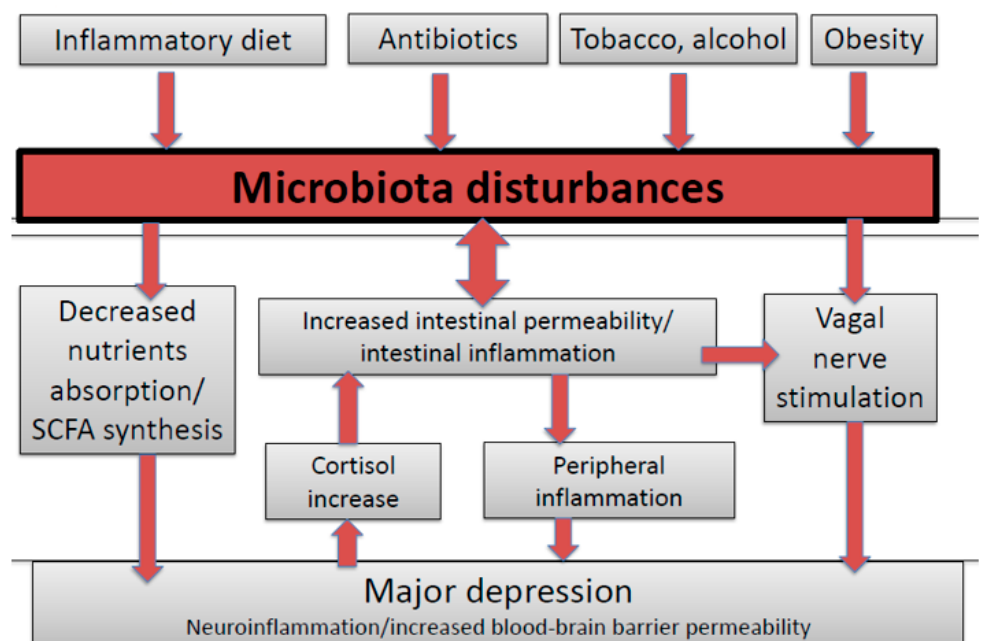
Figure 1. The gut–brain axis in major depression.